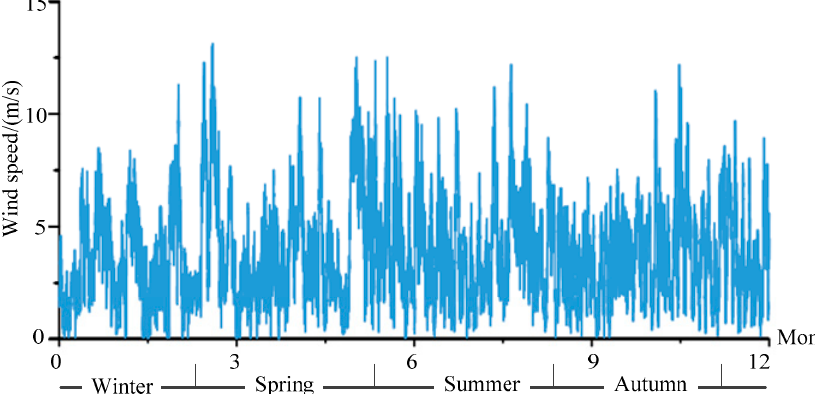
Figure 7. Interannual variation curve of wind speed.